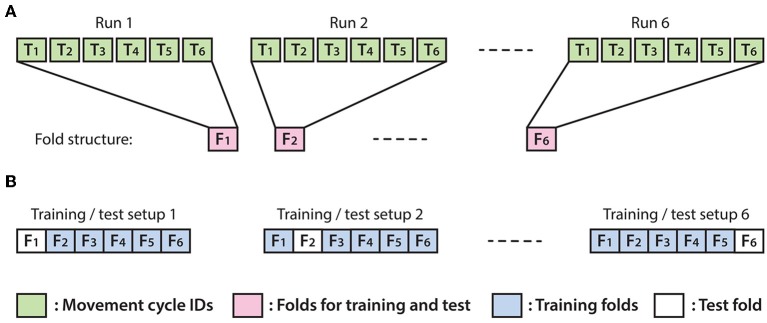
Structure of the applied leave-out-one cross-validation (CV) technique. (A) Each fold was associated with a run and comprised data from the second sub-block in which the virtual arm did not move (imagined arm movements were synchronized with an auditory cue). (B) Illustration of six possible options for separating training and test data using 6-fold leave-out-one CV.